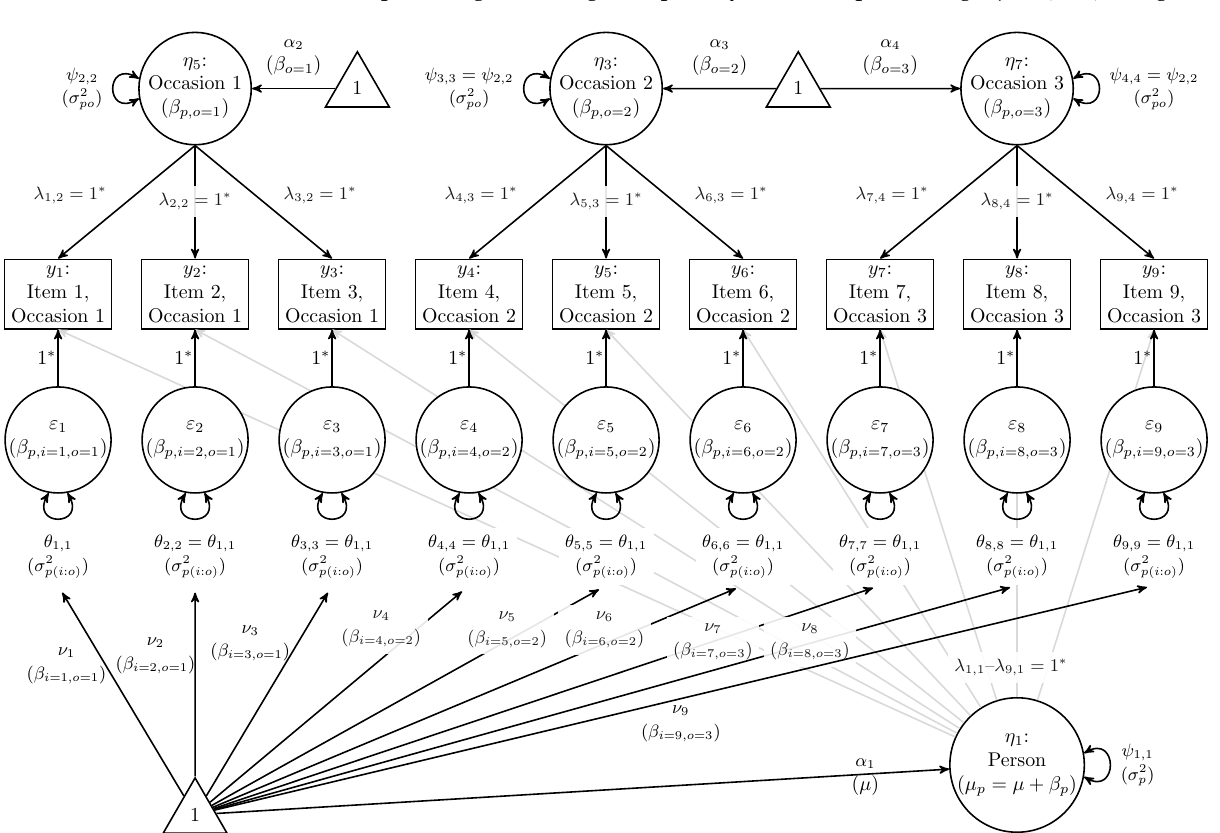
Figure 3. Path diagram depicting p × ( i : o ) GT model represented as a CFA with 9 indicators (items) across 3 occasions as facets of generalization. LISREL (and GT) notation are provided for each CFA variable and parameter. The Person facet (of differentiation) is the first common factor, and the p × o interaction is captured by Occasion factors, whose variances are constrained to equality. Residuals capture the highest-order term, confounded with any other source(s) of error, and their variances are constrained to equality. Identification constraints on the mean structure are listed in Table